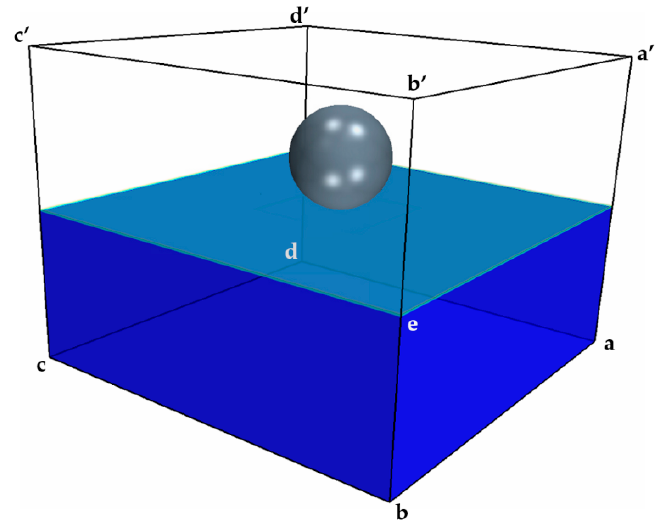
Figure 1. Computational domain.